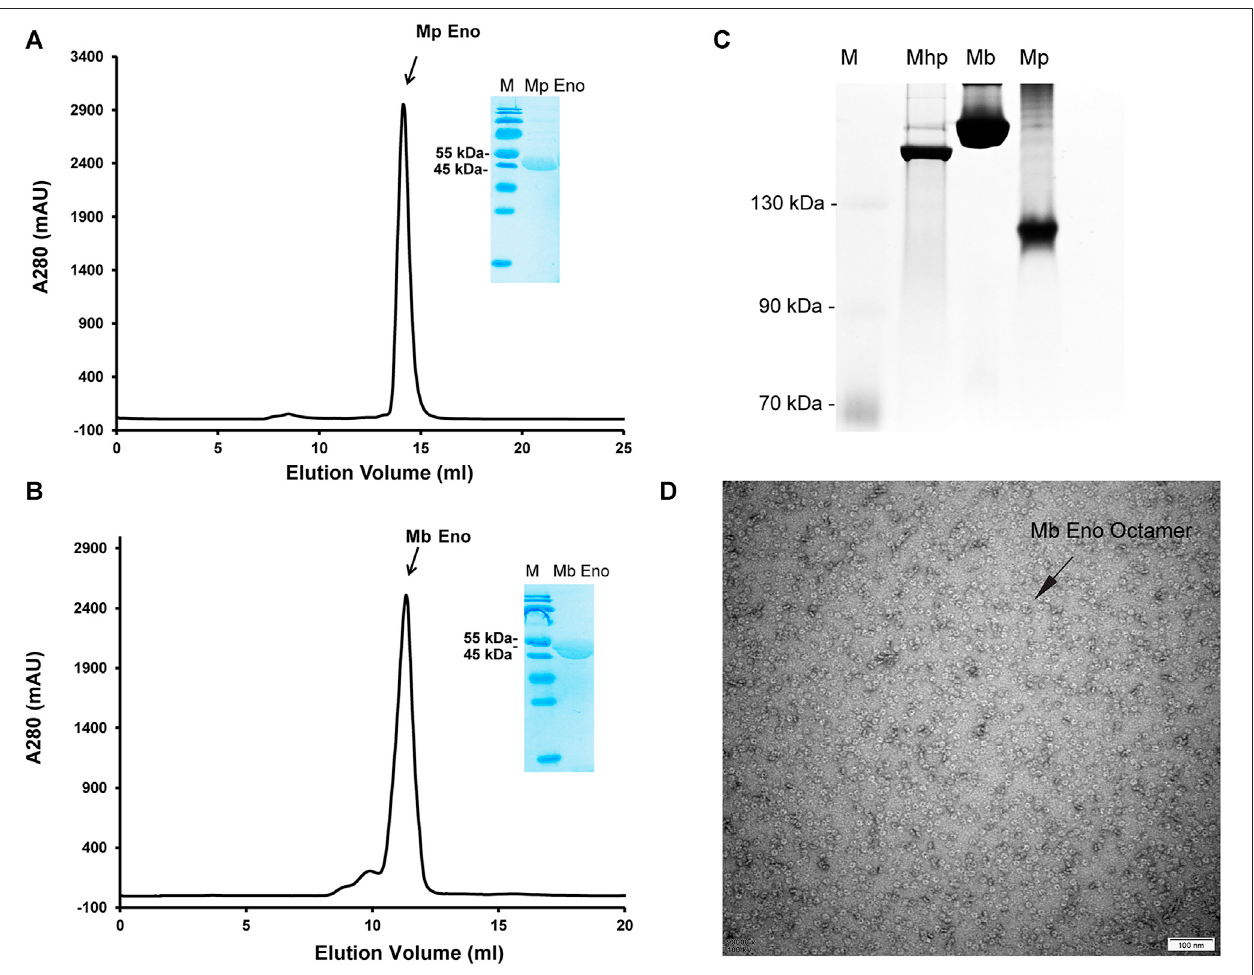
FIGURE3| Mp Enoand Mb Eno oligomeric conformations. (A,B) Gel fi ltration ofMp Eno (A) and Mb Eno (B) .Mp Eno and Mb Enopurities werechecked bySDS- PAGEandareshownintheinsetimages. (C) NativePAGEanalysisofMhpEno,MbEnoandMpEno.Theproteinmarkersizesareindicatedtotherightofthepicture. (D) Negative staining of Mb Eno; the scale is